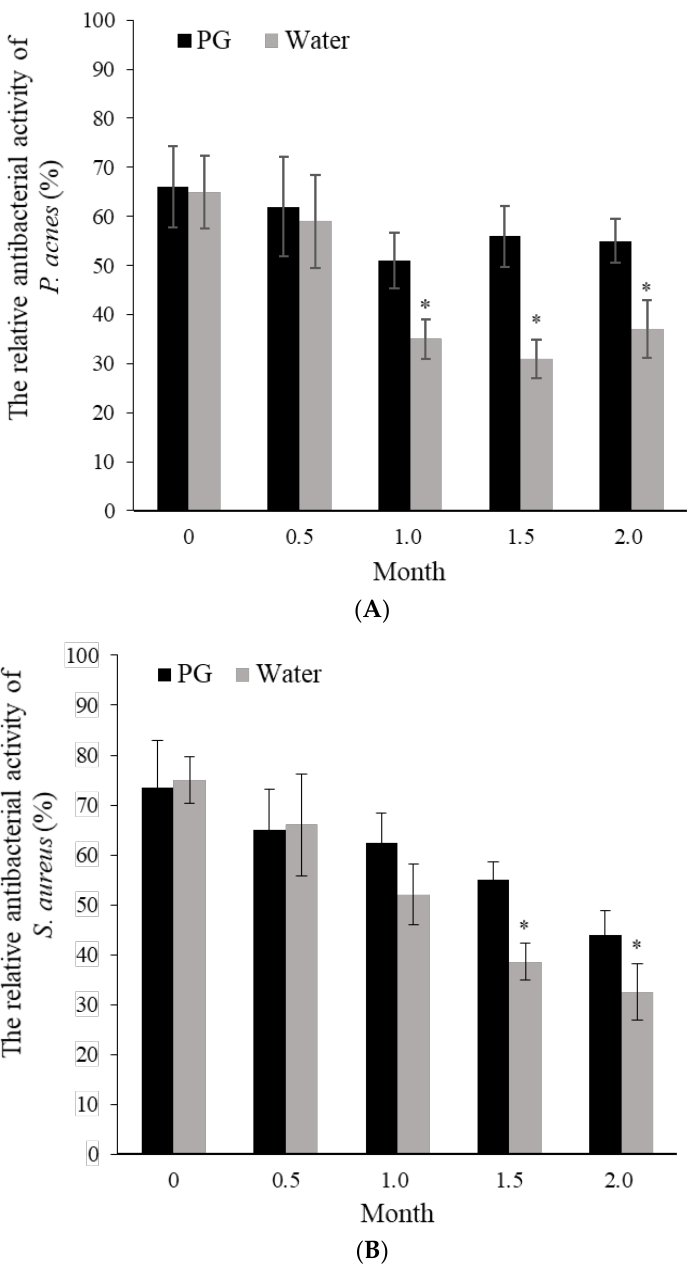
Figure 3. The antibacterial activities against P. acnes ( A ) and S. aureus ( B ) of the Scutellaria baicalensis extract (SBE) stored in 20% PG and water for different numbers of months. The data are presented as the mean ± SD (n = 3). * p < 0.05 compared with the 20% PG solvent.